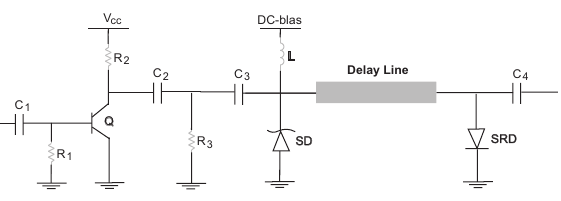
Figure 2: Equivalent circuit of the system.